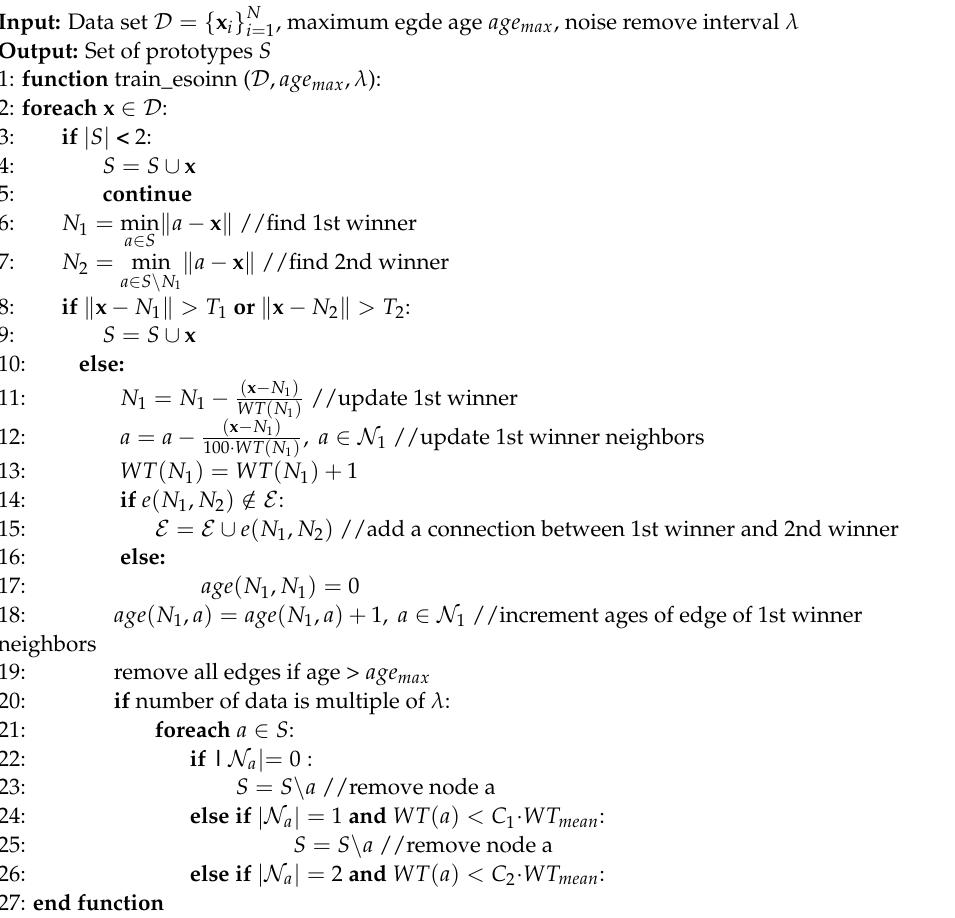
Algorithm 1. Enhanced Self-Organizing Incremental Neural Network